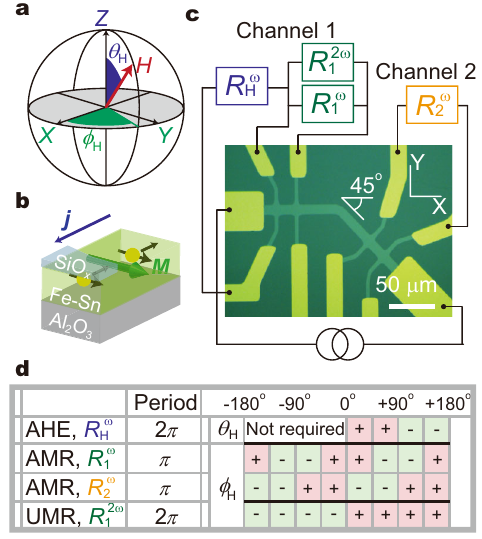
Fig. 1 Detection concept for magnetic- fi eld vector by a Fe – Sn heterostructure device. a De fi nition of the polar ( θ H ) and azimuthal ( ϕ angles of the magnetic- fi eld vector H . b Schematic of layer structure consisting of a SiO x cap and 4-nm-thick Fe-Sn layer grown on Al 2 O 3 substrate. Magnetization of the Fe-Sn layer follows the magnetic fi eld, providing resistance changes with respect to strength and direction of the fi eld. c Top-view photograph of the planar Hall device and measurement setup. d Summary of the signal output from AHE, AMR, and